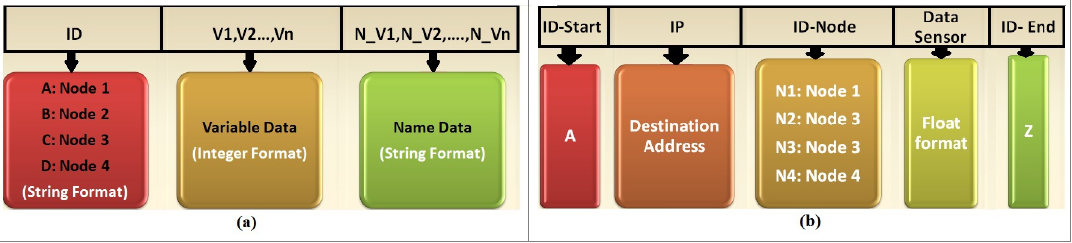
Figure 3. Structure of data transfer packages: ( a ) ZigBee and DigiMesh networks; and ( b ) WiFi